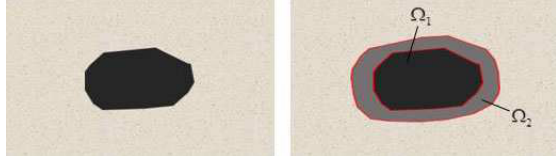
Figure 4. An illustration of an unknown region to be completed with a dilation operation: (Left) the original missing part; (Right) the dilated